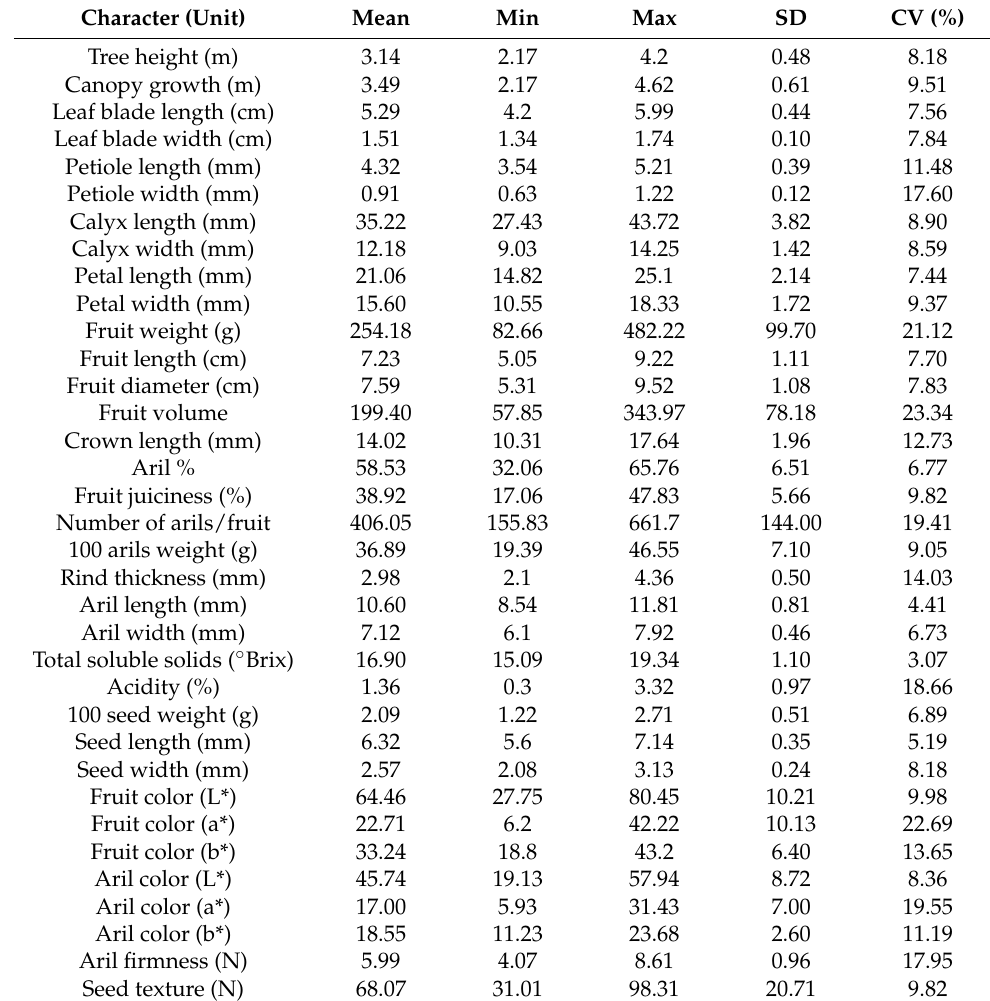
Table 1. Descriptive statistical analysis of quantitative traits used for characterization of pomegranate accessions. SD: standard deviation; CV: coefficient of